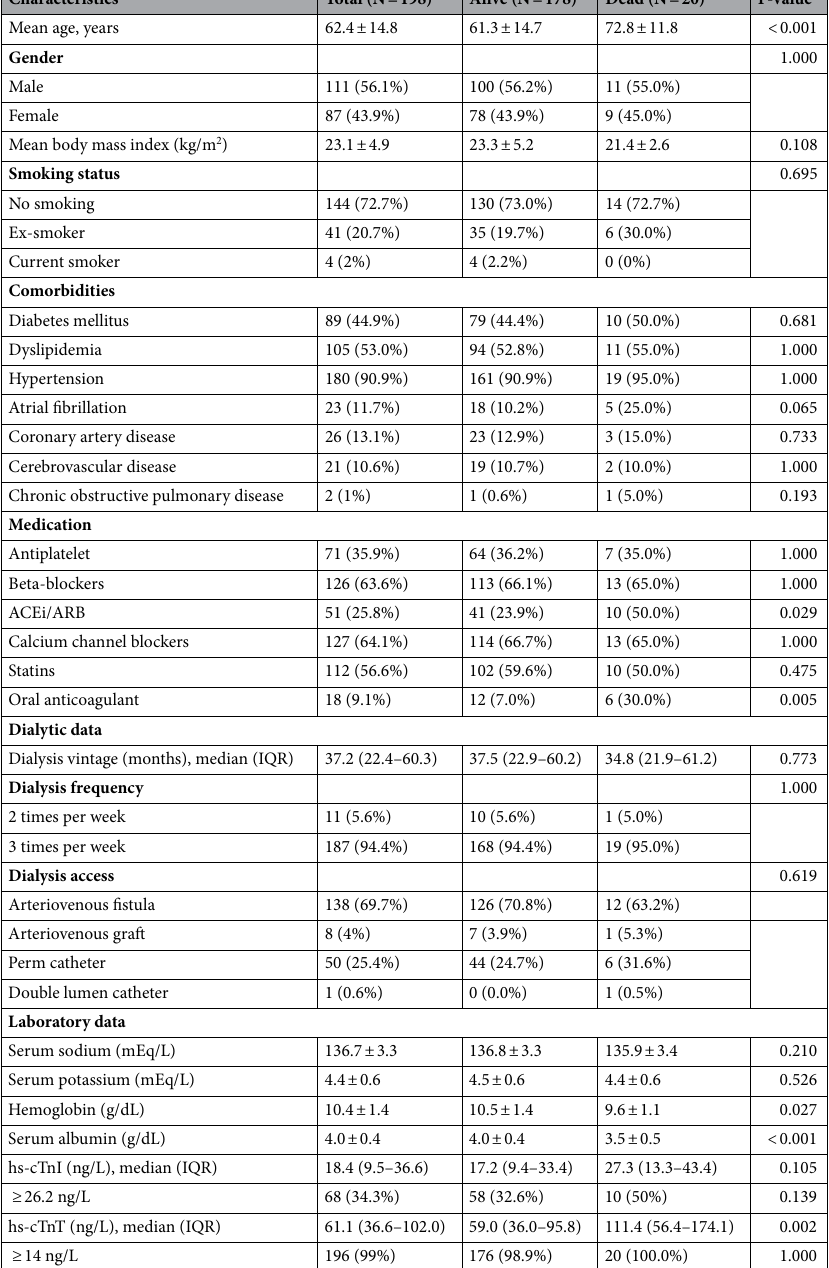
Table 1. Baseline characteristics of the